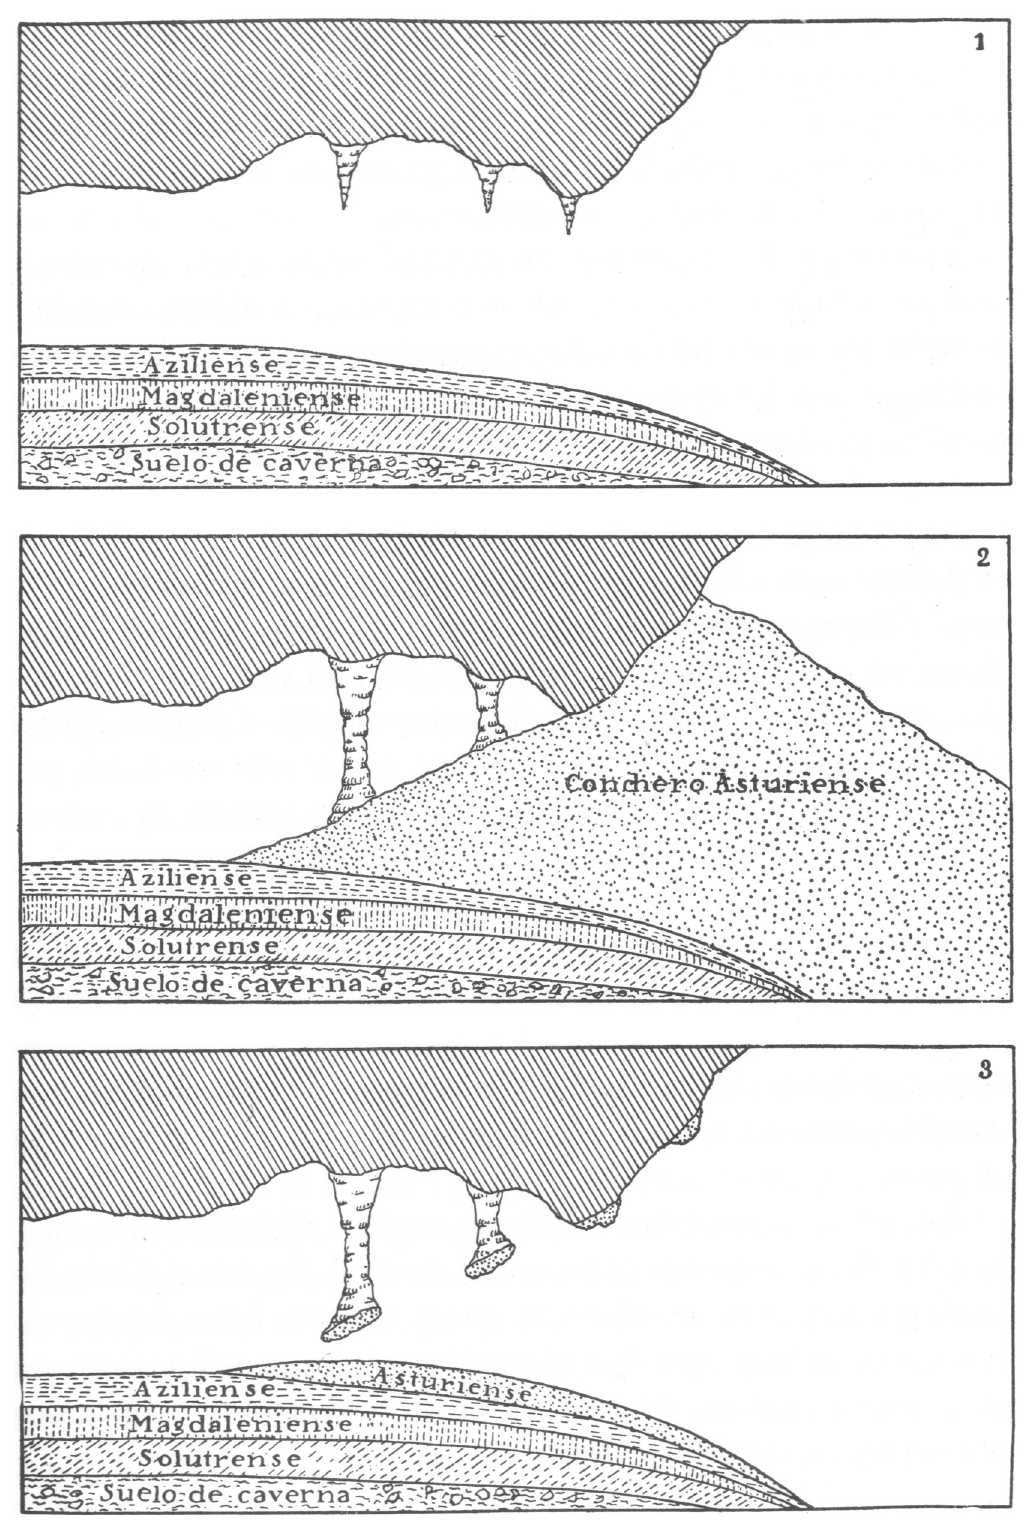
Figure 2: Formation and erosion of Asturian shell - middens in caves, according to Vega del Sella ( 1923, p. 11 ) : 1. at the end of the Palaeolithic, 2. during the Asturian, and 3.